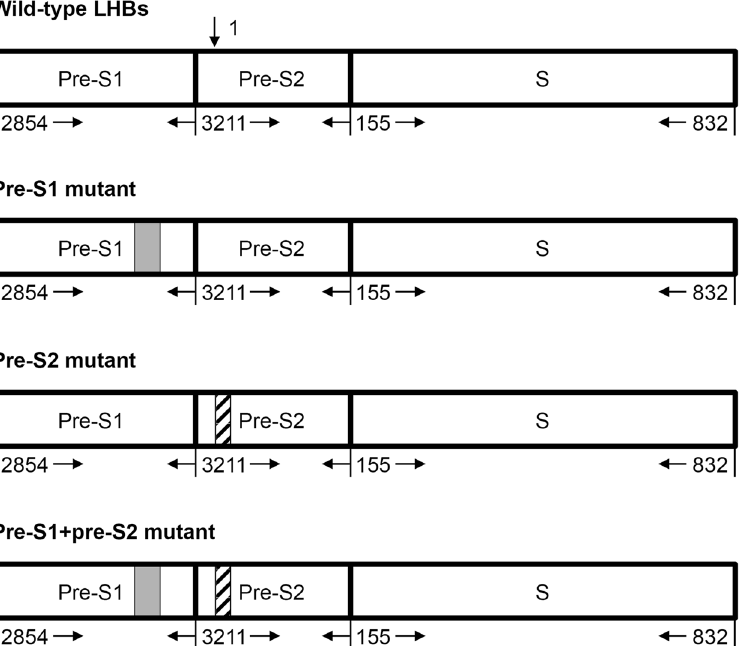
Figure 1. Schematic representation of the wild-type and pre-S mutant LHBs gene. The wild-type LHBs gene contains three intact gene segments, pre-S1, pre-S2, and S. The numbers on the bottom of the gene indicate the nucleotide positions of each gene segment in the HBV genome. The arrow at the top of the diagram indicates the start (nucleotide 1) of the circular genome, and the numbers go clockwise and end at nucleotide 3221 (not shown). Here only the LHBs gene of the genome is shown. The pre-S1, pre-S2, and pre-S1 + pre-S2 mutants contain deletion mutations in the pre-S1, pre-S2, and both pre-S1 and pre-S2 gene segments, respectively. The grey and hatched boxes represent the regions deleted in the pre-S1 and pre-S2 gene segments,